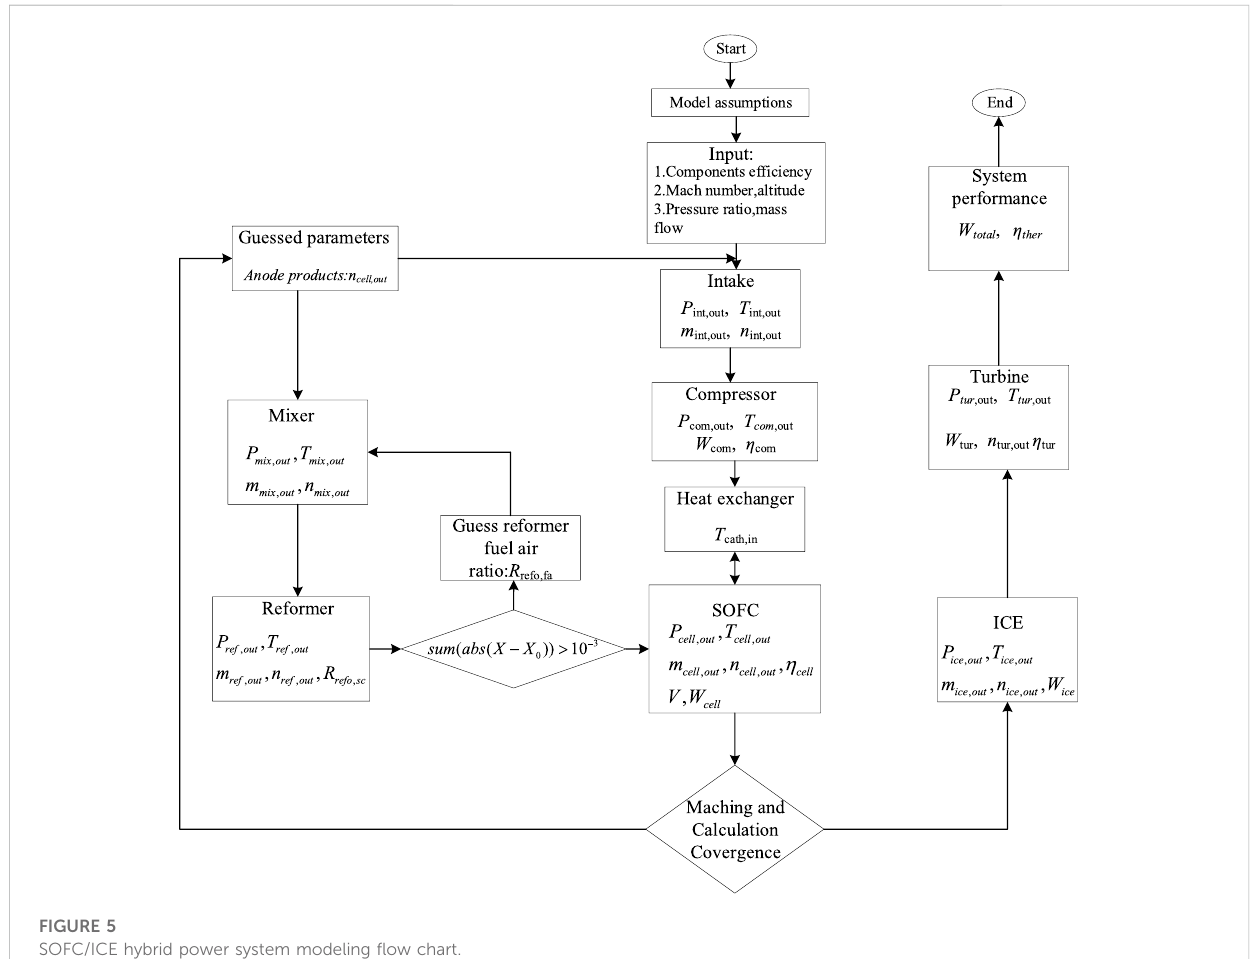
FIGURE 5 SOFC/ICE hybrid power system modeling fl ow